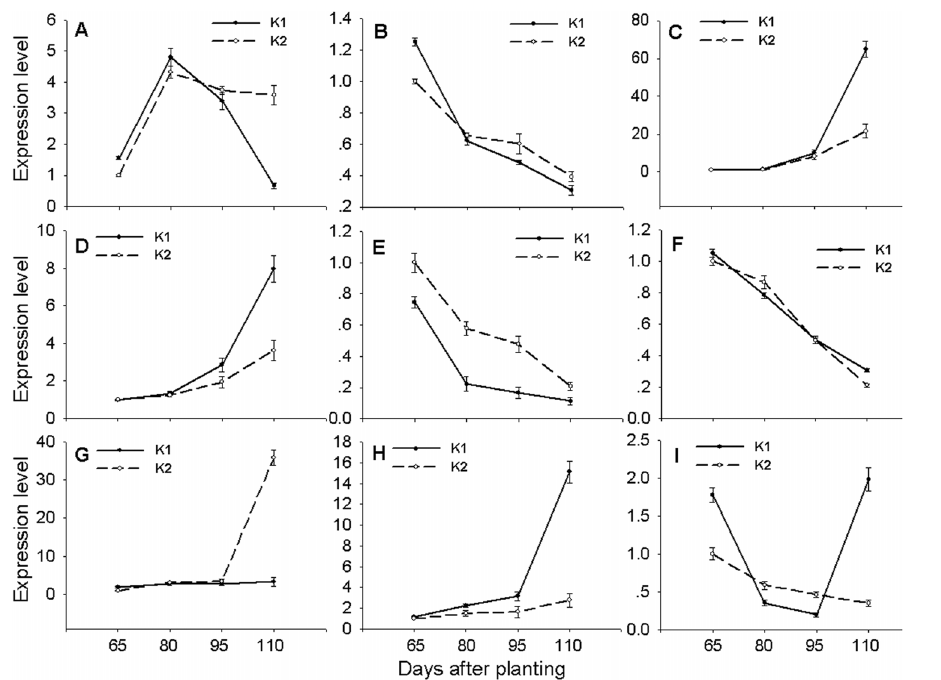
Figure 3. Senescence-dependent changes in gene expression determined by quantitative RT-PCR in the main-stem leaves of K1 and K2 cotton lines at 65, 80, 95 and 110 DAP. A, Chlorophyll binding protein ( LHCB ; gene ID: EX169337). B, Large subunit of Rubisco, ribulose- 1,5- bisphosphate carboxylase/oxygenase ( RBCL ; gene ID: ES820978). C, Superoxide dismutase ( SOD ; gene ID: ES824305). D, Autophagy ( ATG ; gene ID: CO493577). E, Isopentenyltransferase ( IPT ; gene ID: DW494123). F, 9-cis-epoxycarotenoid dioxygenase ( GhNCED2 ; gene ID: HM014161); G, 9-cis- epoxycarotenoid dioxygenase ( NCED1 ; gene ID: EX168449). H, NAC domain protein ( NAC ; gene ID: CA992724). I, NAC domain protein ( GhNAC6 ; gene ID: Dw517699). Expression ratios are presented relative to K2 values at 65 DAP. Data are means of three biological replicates 6 SE.